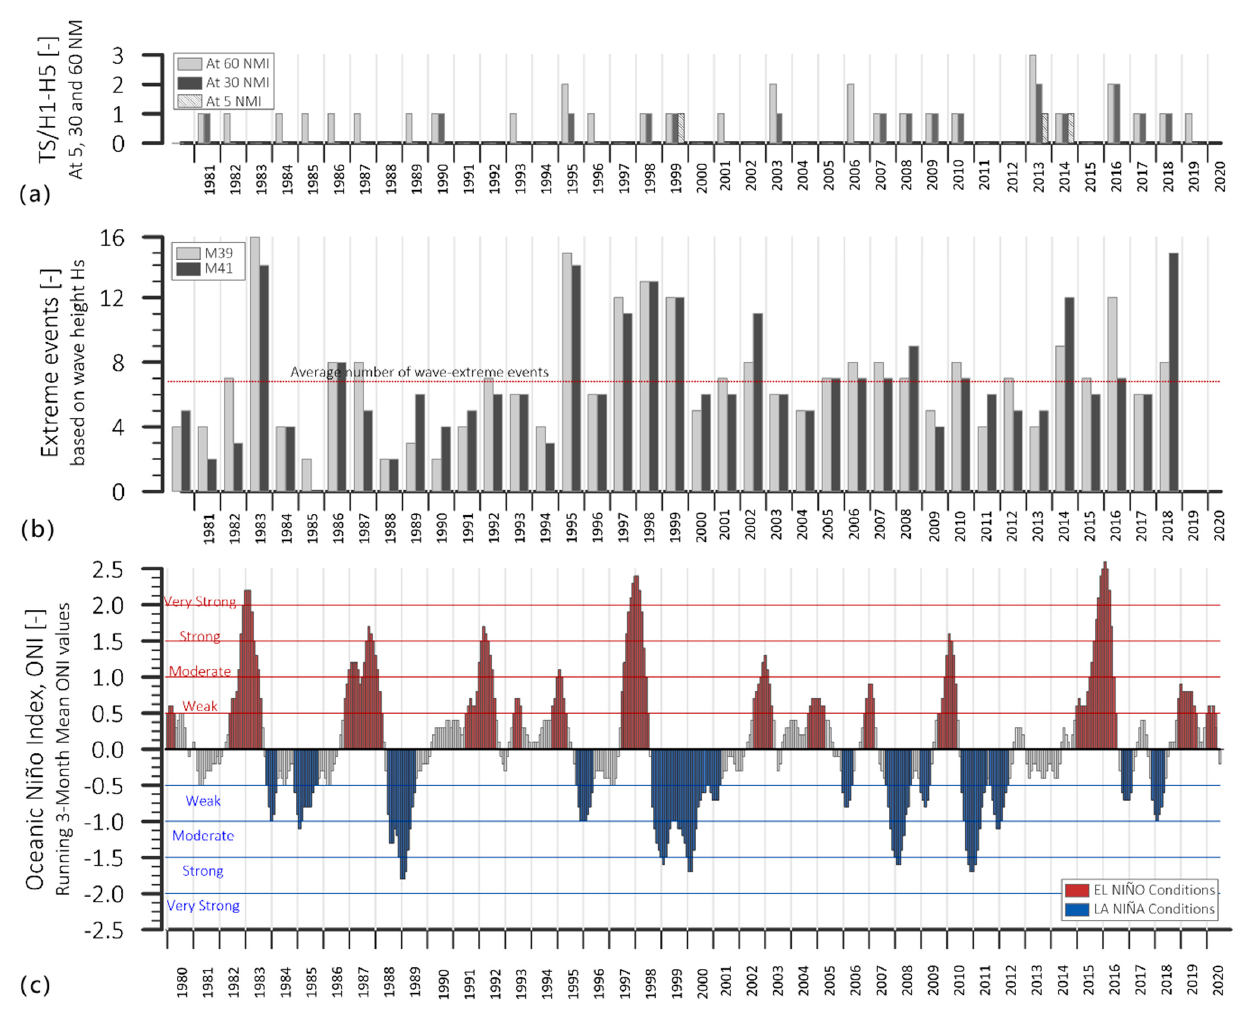
Figure 4. Historical occurrence of ( a ) tropical storms (TS) and hurricanes (H1–H5) at a radius of 30 and 60 NM from Cabo San Lucas [63]; ( b ) storms, as defined by the significant wave height data from numerical buoys M39 and M41; and ( c ) Oceanic Niño Index (ONI) [51].